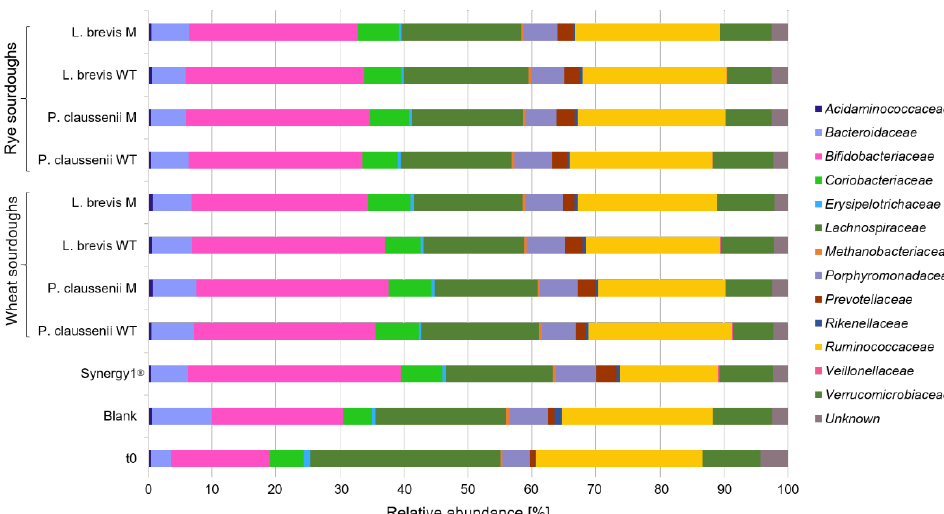
Figure 1. Relative abundance [%] of bacterial families in fermentation pellets (FP) of controls (blank, Synergy1 ® ) and in FP of wheat and rye sourdoughs obtained after sourdough fermentation with wild-type (WT) and mutant (M) strains of Pediococcus claussenii (WT: TMW 2.340, M: TMW 2.2123) and Levilactobacillus brevis (WT: TMW 1.2112, M: TMW 1.2320). TMW: Technische Mikrobiologie Weihenstephan.